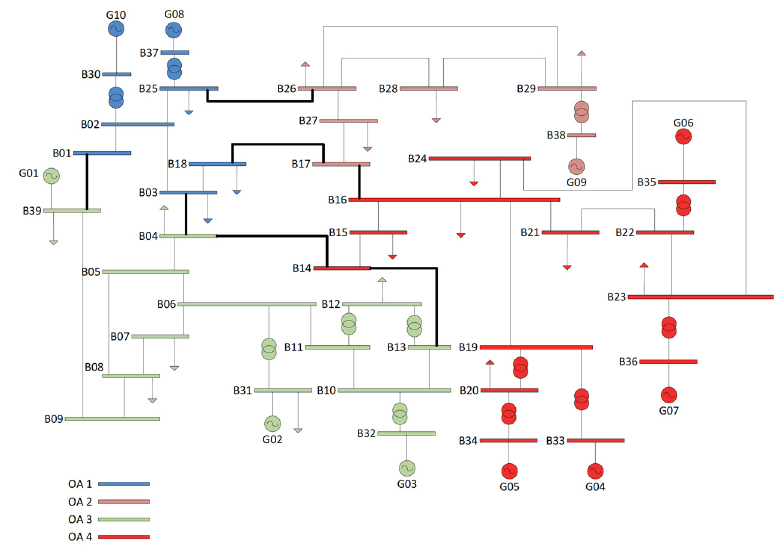
Figure 9. IEEE 39-Bus System.